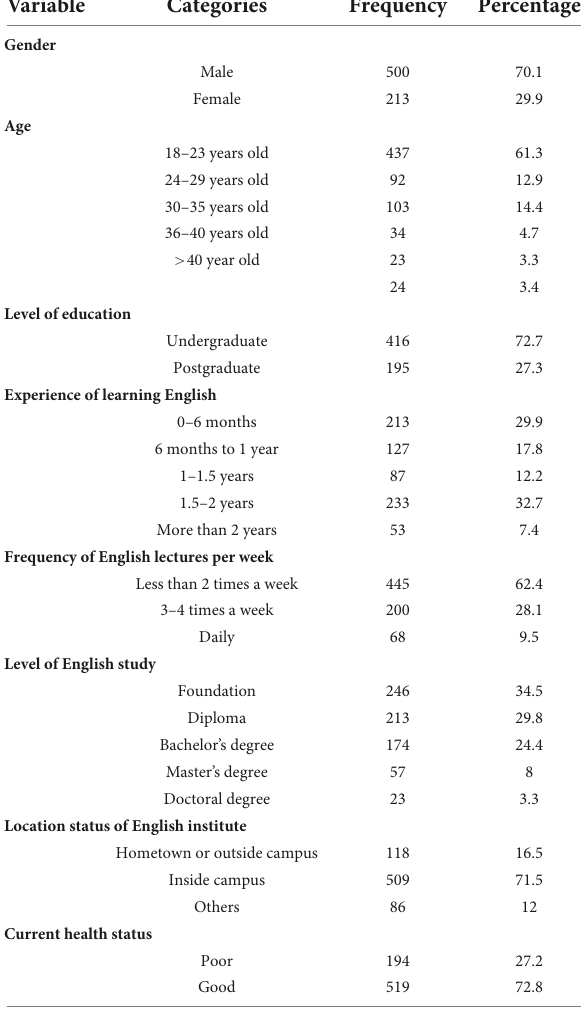
TABLE 1 Respondents’ demographic